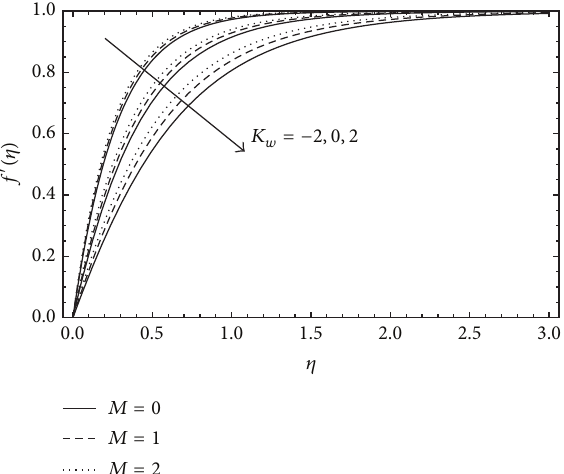
Figure 7: Variation of velocity profiles with 𝐾 𝑤 (−2,0,2) for 𝑀 = 0, 1, 2 .